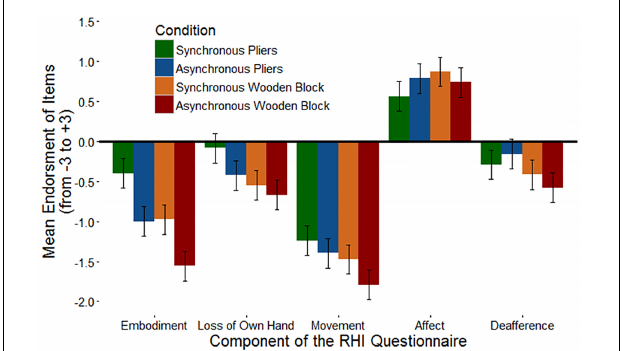
FIGURE 5 | The non-significant interaction between RHI condition and questionnaire component for the pliers-version of the RHI. Error bars represent ± 1